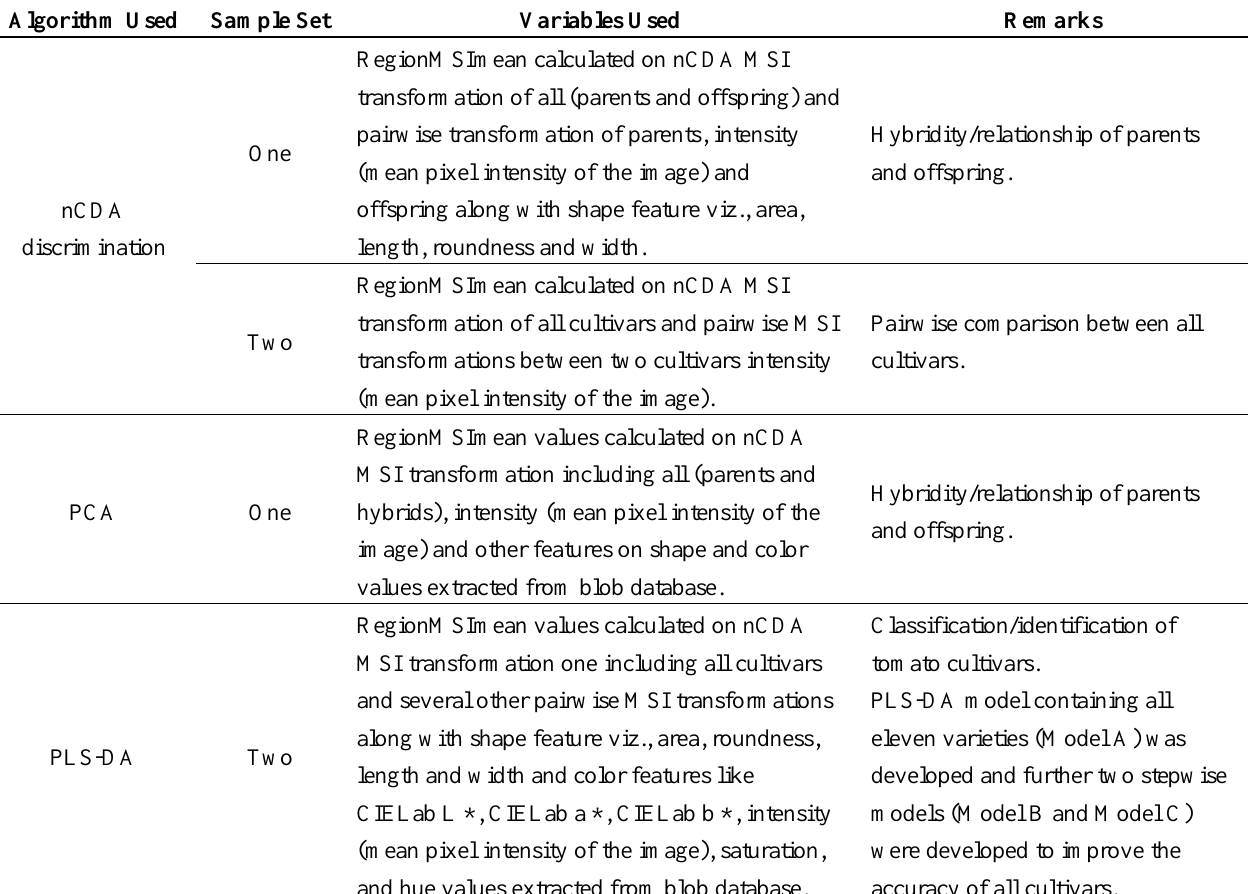
Table 2. Overview of data